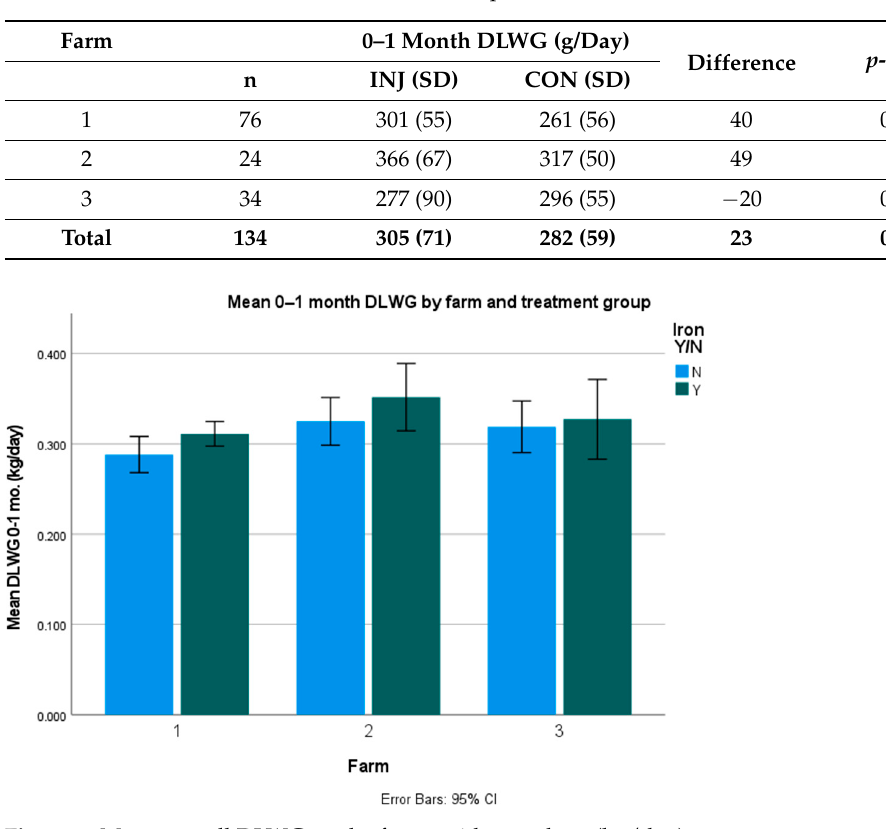
Table 6. Mean 0–1-month DLWG in twins and triplets on the three farms.